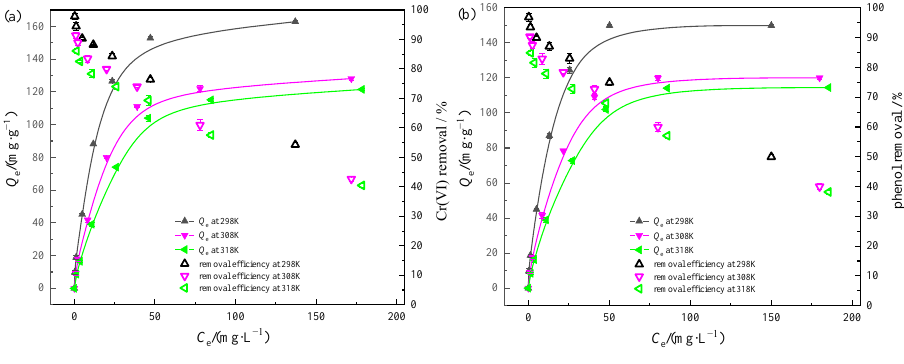
Figure 6. Adsorption isotherms of ( a ) Cr( Ⅵ ) on S1 and ( b ) phenol on S2. Fitting curves and adsorption isotherm constants for Cr( Ⅵ ) adsorption on S1 are shown in Figure 7 and Table 3. According to the desired R 2 greater than 0.99, the adsorption behavior of Cr(VI) on the adsorbent surface is deemed to be better described by the Langmuir adsorption isotherm equation, indicating that Cr(VI) was mainly adsorbed by monolayer. This was because, after the monolayer adsorption of Cr(VI) on the surface of the adsorbent, the excess Cr(VI) did not easily approach the surface of the adsorbent due to the existence of electrostatic repulsion. According to the fitting parameters in Table 3, the saturated adsorption capacity of Cr(VI) at 298 K reached 174.22 mg · g − 1 . The n values fitted by the Freundlich adsorption isotherm equation were all greater than 1, indicating that the adsorption of Cr(VI) on S1 were beneficial adsorption processes [51]. At 298 K, the n value was between 2 and 10, indicating that the adsorption of Cr(VI) on S1 more easily occurred at room temperature [52].